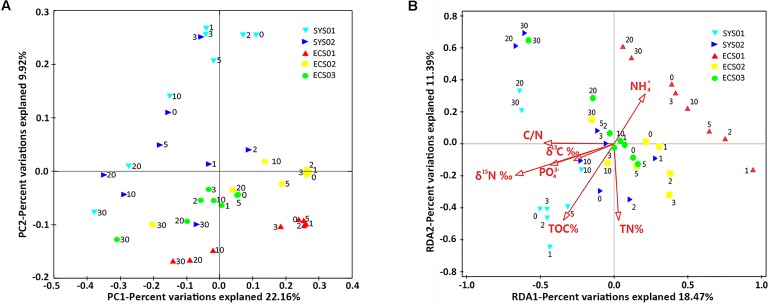
Community analysis at the OTU level. (A) Unweighted PCoA plot with PC1 and PC2. (B) RDA analysis illustrating the relationship between bacterial community at the OTU level and top environmental variables.